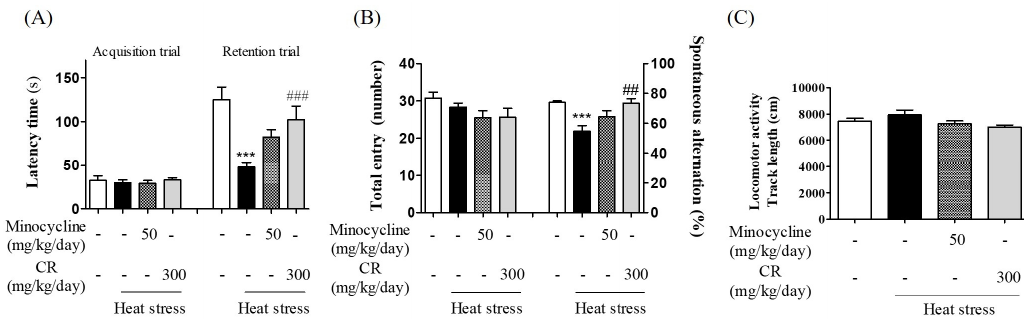
Figure 8. Protective effects of CR on thermal stress ‐ induced cognitive deficits. ( A ) We determined cognitive function using a passive avoidance task. ( B ) We also performed the Y ‐ maze task to evaluate the memory function. ( C ) We conducted the open ‐ field test to rule out the heat ‐ induced sickness behavior. Values are expressed as means ± SEM. *** p < 0.001 as compared with the control group. ## p < 0.01 and ### p < 0.001 as compared with the heat ‐ exposed vehicle ‐ treated group.